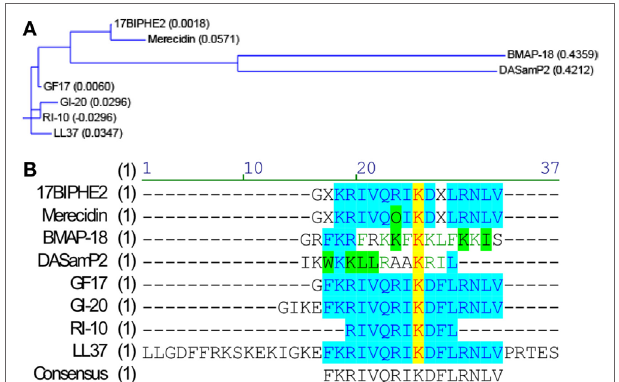
FigUre 1 | Sequence relationships of the nine peptides. Sequence relationships of the nine antimicrobial peptides (AMPs). Amino-acid sequences of the AMPs were compared with the Vector NTI software suite (Thermo Fisher Scientific). (a) Working relationships between the nine AMPs derived from human and bovine cathelicidins are shown in the dendrogram based on the amino-acid sequence homology. The length of each tree branch is proportional to the number of amino-acid differences between a particular sequence and its theoretical ancestral sequence (presented as parentheses for each sequence). (B) Amino-acid sequence alignment. Color codes indicate degree of similarity: yellow, font red: identical; cyan, font blue: conservative; green, font black: similar; no color, font green: weakly similar, no color, font black: